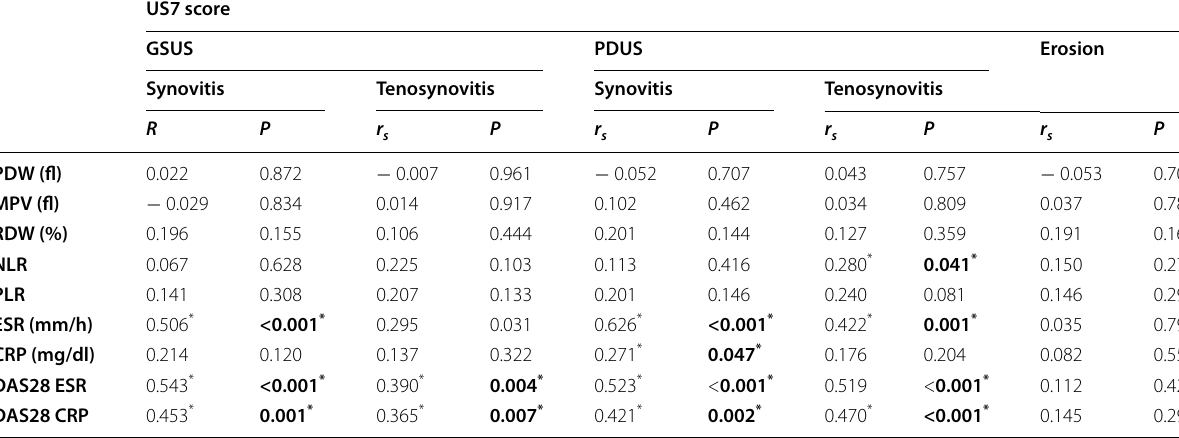
Table 5 Correlation between US7 score and laboratory investigation and DAS